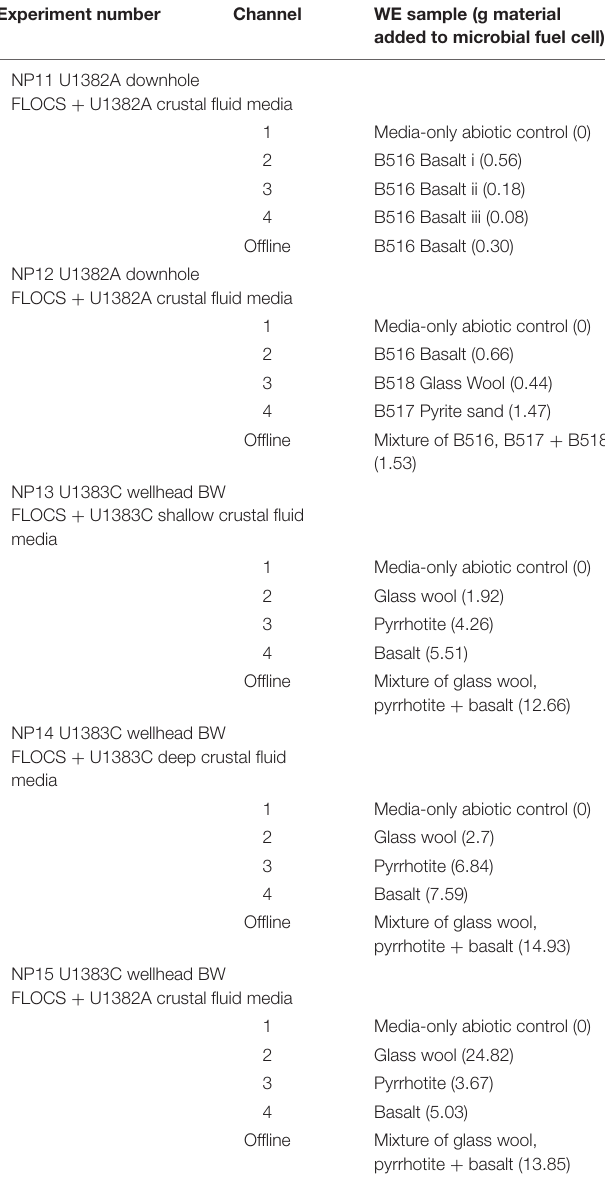
TABLE 2 | Summary of poised potential experimental set-ups, indicating contents of the working electrode (WE) cell, the media used in the cells (ultra-filtered and double autoclaved fluid from either CORKs U1382A or U1383C supplemented with 10 mM sodium bicarbonate as a buffer). Experiment number Channel WE sample (g material added to microbial fuel